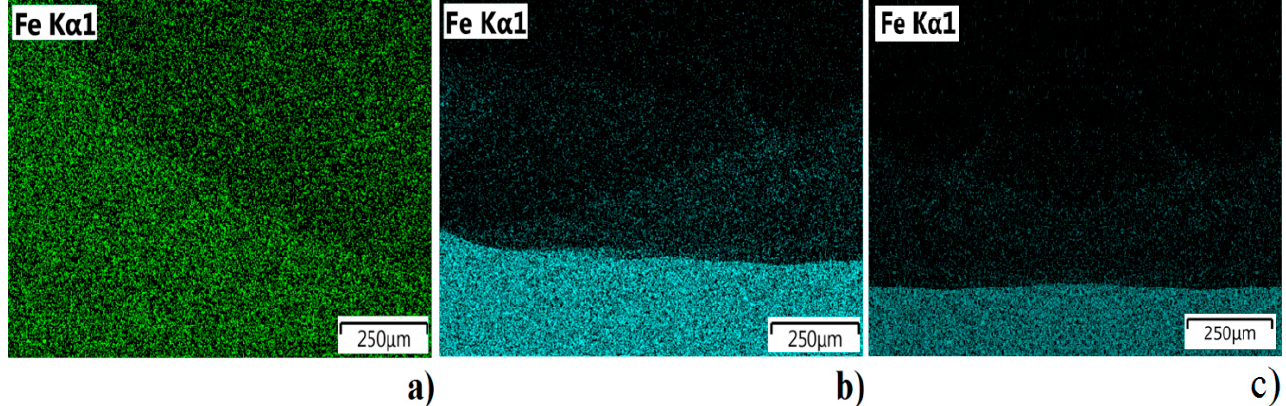
Figure 11. Iron distribution between the second and third layer for: ( a ) wire deposition, ( b ) developed S-HDM, ( c ) pow- der deposition.